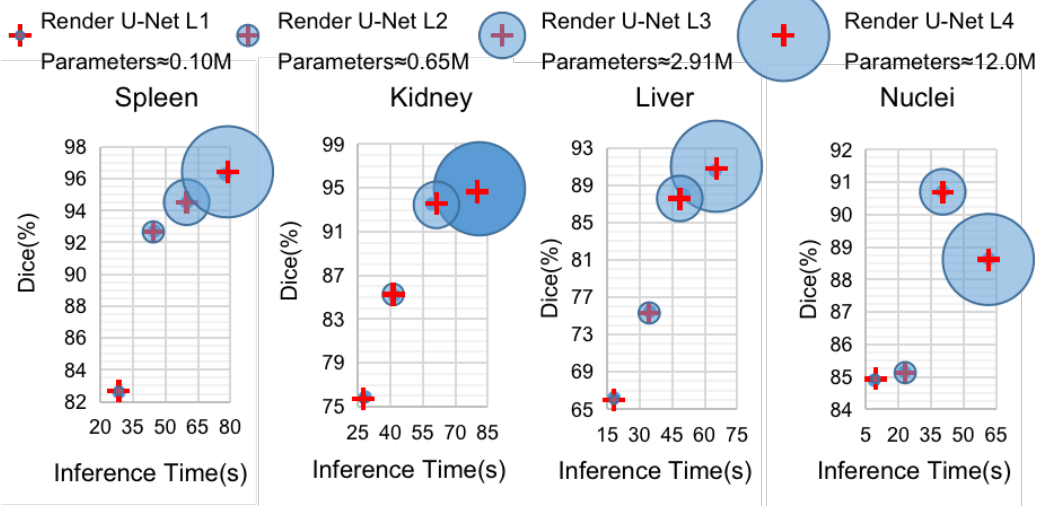
Figure 16. Diagram of the relationships between the Dice coefficients and inference times of the four pruned Render U-Nets with segmentation of four kinds of objects. We use four blue circles with different areas to denote sub-networks with different parameter